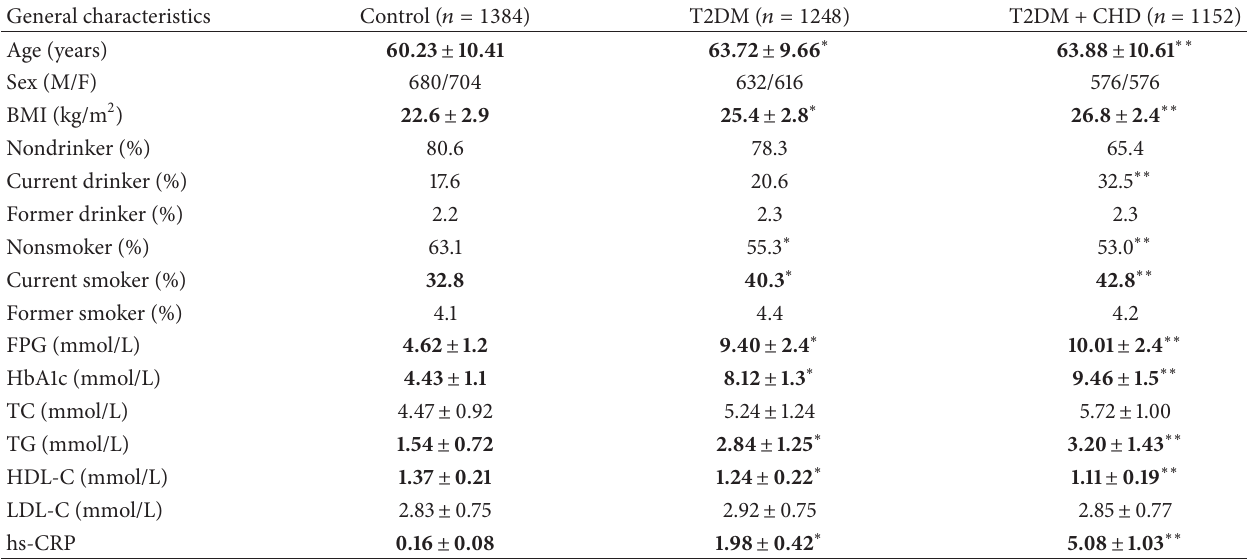
Table 1: General clinical characteristics of the study